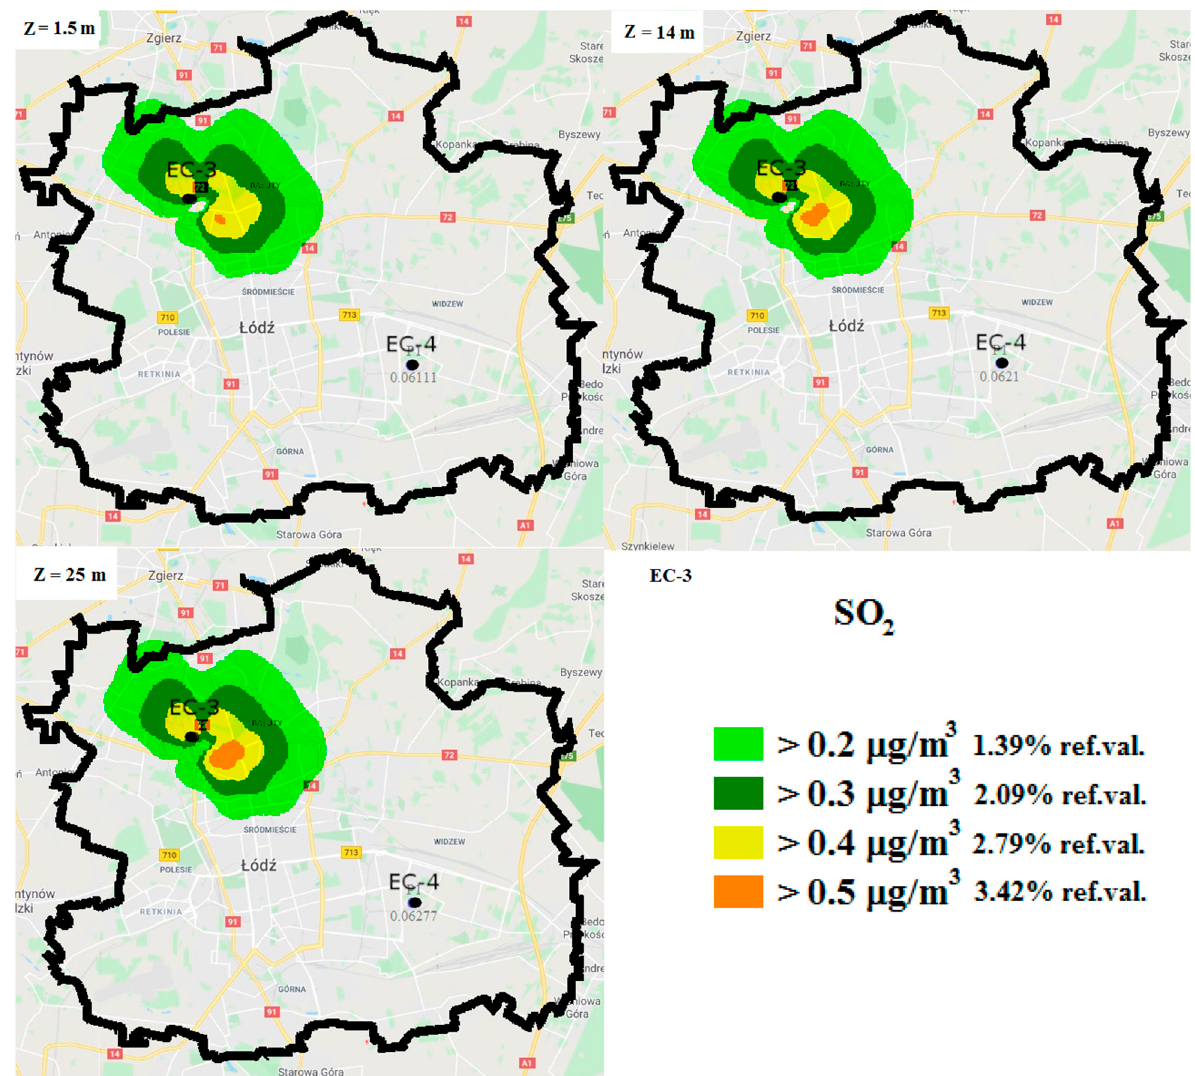
Figure 8. Distribution of annual average SO2 concentrations at the height of 1.5, 14, and 25 m surrounded by EC-3 in 2019 based on the results from OPA03.